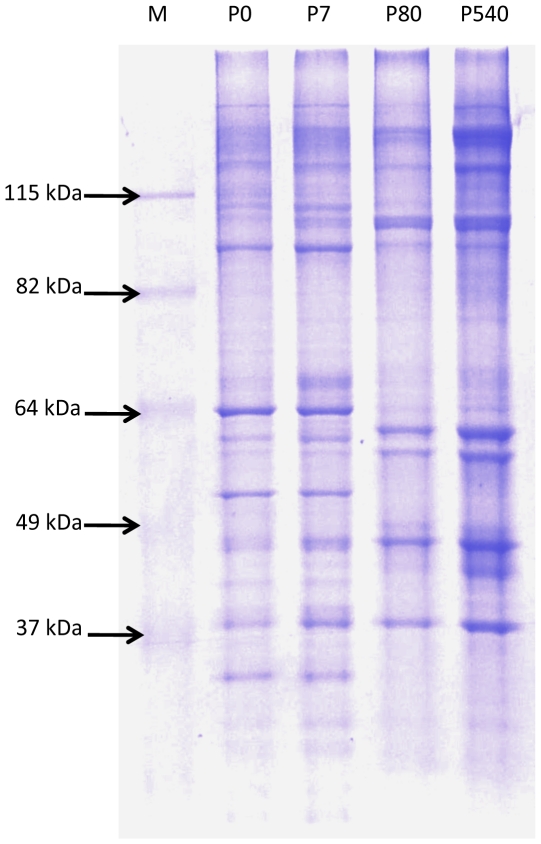
SDS-PAGE protein profiles of neuronal NM from different post-natal ages.Experimental lanes were loaded with 15 µg of the corresponding NM-protein extract. Notice the quantitative changes in the protein profiles between the early (P0, P7) and late (P80, P540) sampled ages. M, molecular weight ladder.